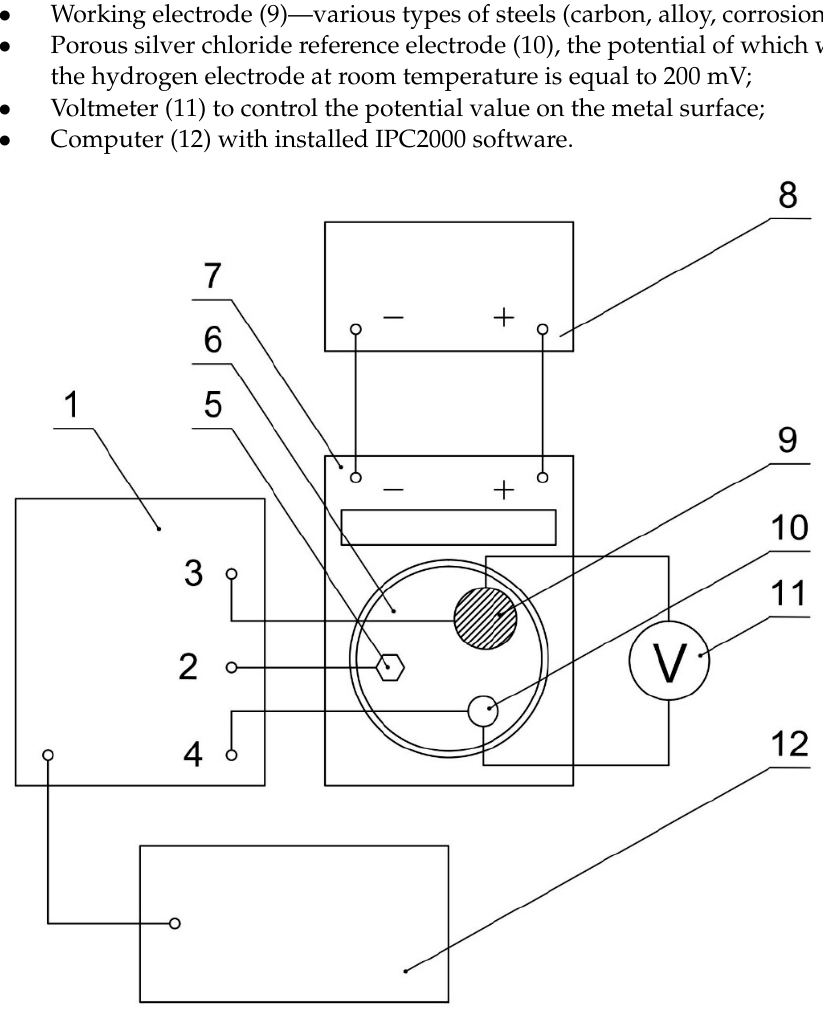
Figure 3. Test facility for studying the electrochemical characteristics of hull structures of ships and floating facilities on the juvenile surface under cathodic polarization [42]. A model seawater solution was used for the experiment. Powdered NaCl and distilled water were used to prepare the solution. Figure 4 shows the process of preparing a model solution of seawater with a salinity of 18‰, which requires 9 g of powdered NaCl and 500 mL of distilled